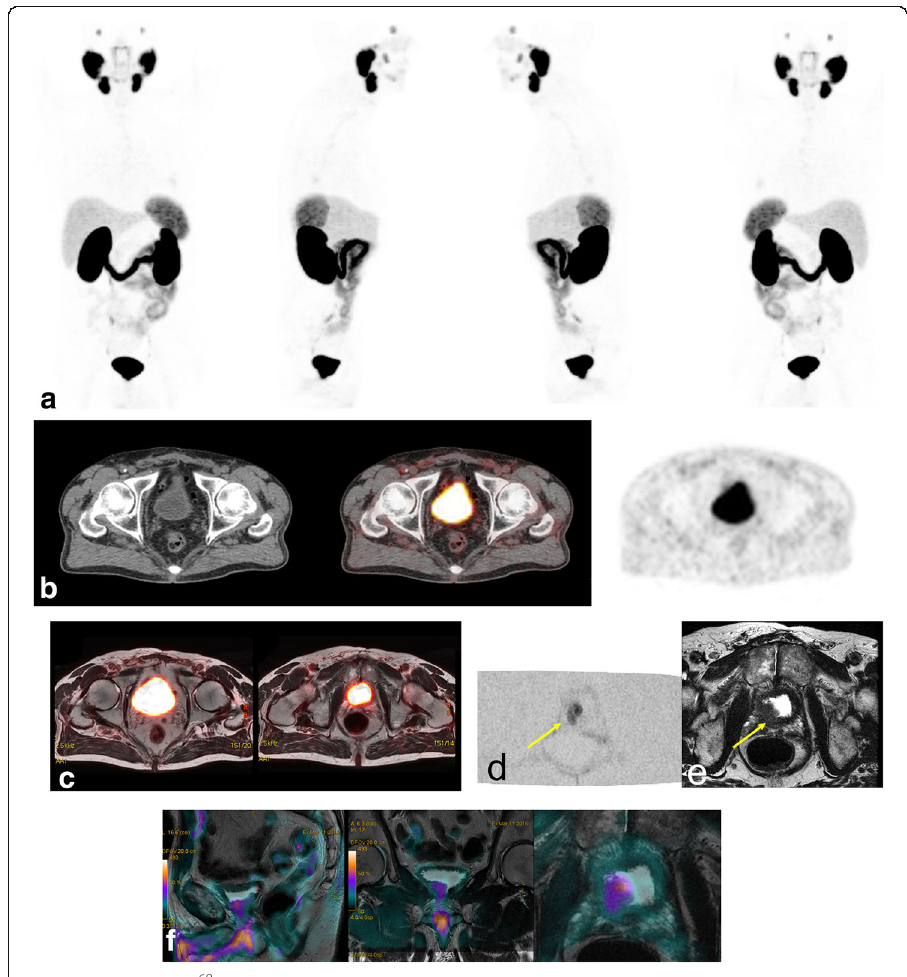
Fig. 5 Patient 36. MIP 68 Ga-PSMA images ( a ) of a 68-year-old patient with PCa treated with surgery with current elements of biochemical relapse (PSA level 0.2 ng/ml). 68 Ga-PSMA PET/CT ( b ) and 68 Ga-PSMA PET/MR images ( c ) without abnormal pelvic findings. DWI ( d ) and high-resolution T2 ( e ) MR scans show a local relapse lesion with restriction (arrows) that was hidden by physiological tracer bladder activity. The hypointense lesion involves the infundibulum in the right posterolateral prostate region. MR-DWI fusion images are shown in ( f